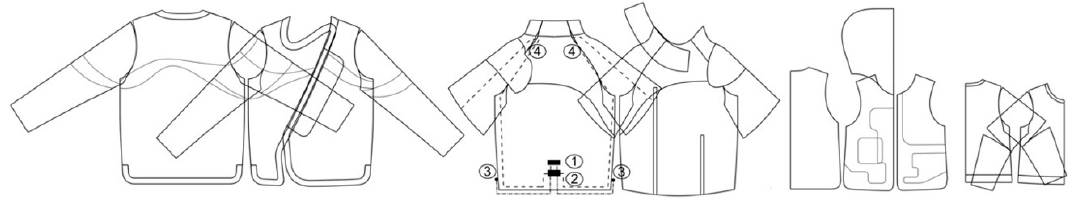
Figure 2. Pattern design and hardware embedding.